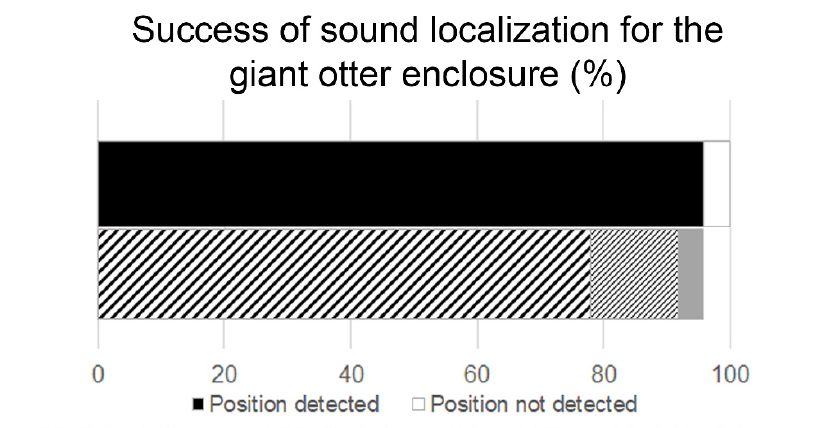
Figure 5. Success of sound localization for the giant otter enclosure in percent. In 96% of the cases, the software LASER was able to correctly estimate the position of the vocalization (black upper bar). Only in 4% of the cases the position could not be recognized correctly (white upper bar). The 96% are divided into 78% in which the individual emitting the sound could be detected (lower thick-striped bar), 14% in which the software LASER was able to estimate the position of the vocalizing animal very precisely and with a small probability range (ellipse spanning 50% of the intersections); however, two animals were very close to each other within this probability range (lower thin-striped bar) and 4% in which the probability range was large enough to include several individuals.